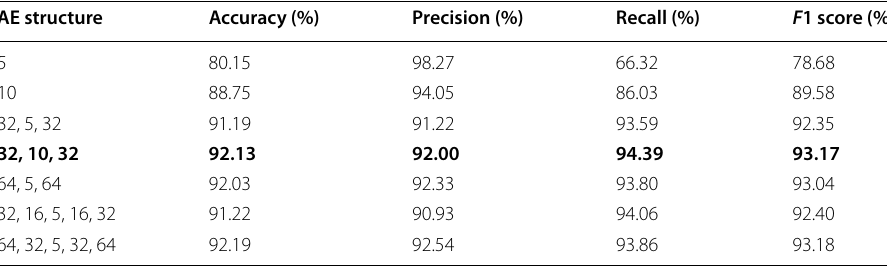
The best-performance AE structure is marked with bold styles Table 8 Performance of the proposed model under different thresholds AE threshold Accuracy (%) Precision